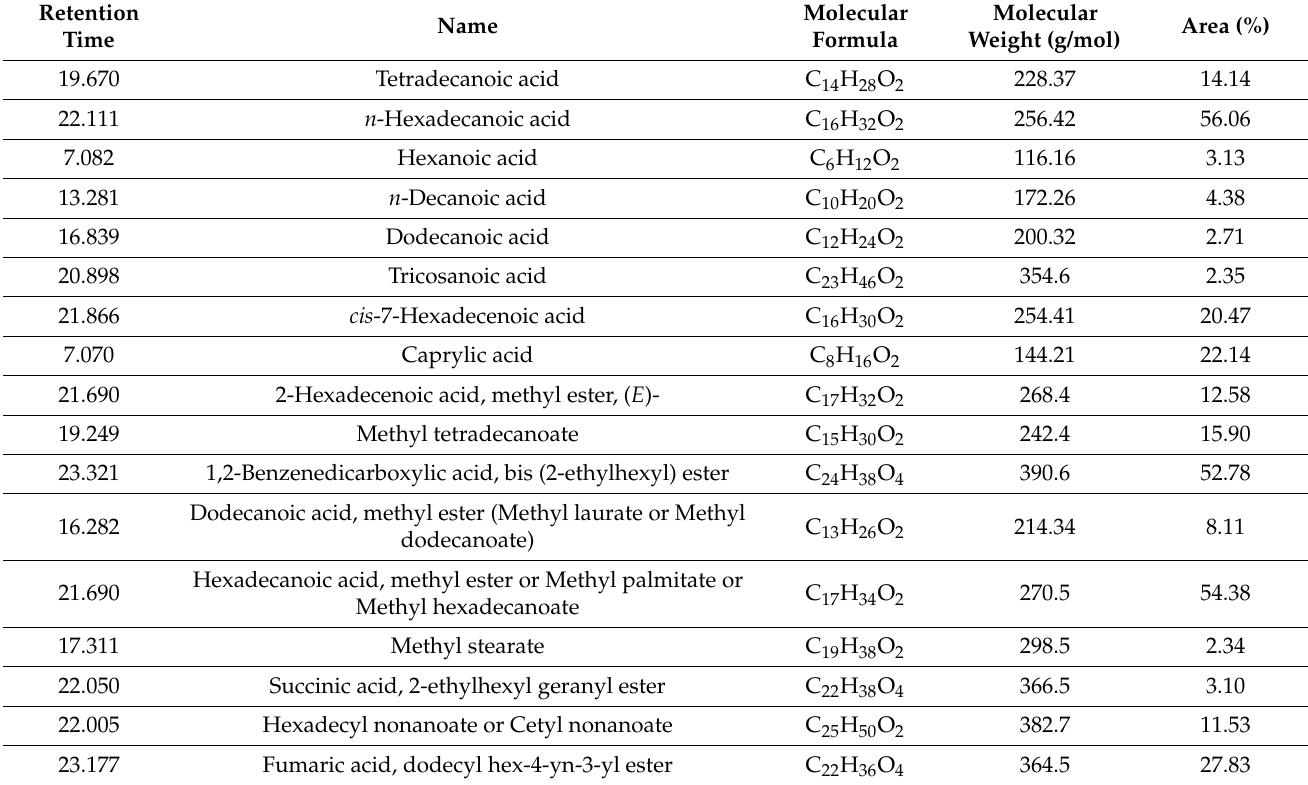
Table 1. Metabolites found in milk samples by GC-MS